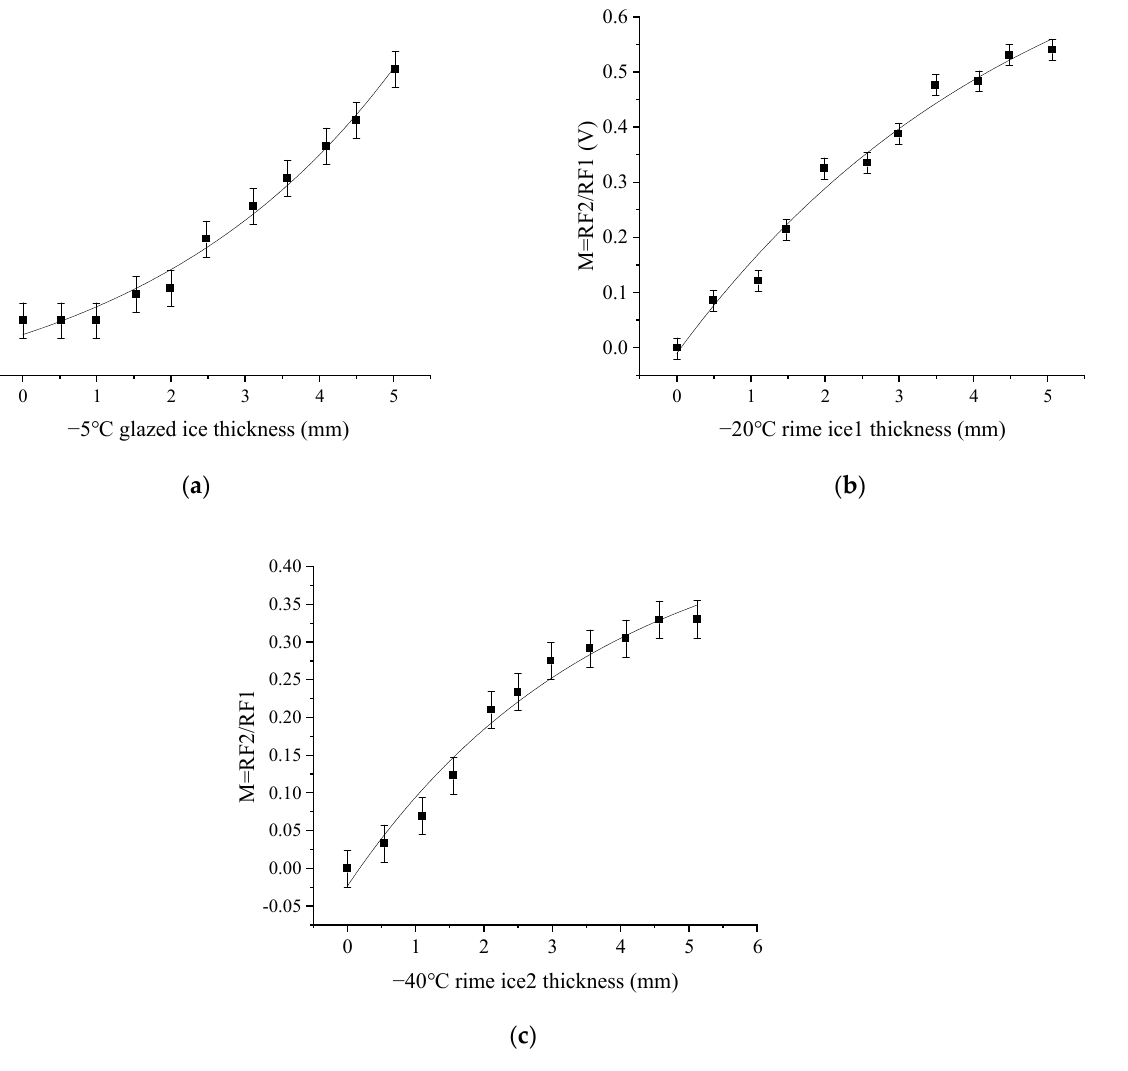
Figure 10. Relationship between the light intensity modulation function and ice thickness. ( a ) − 5 °C glazed ice; ( b ) − 20 °C rime ice 1; ( c ) − 40 °C rime ice 2.